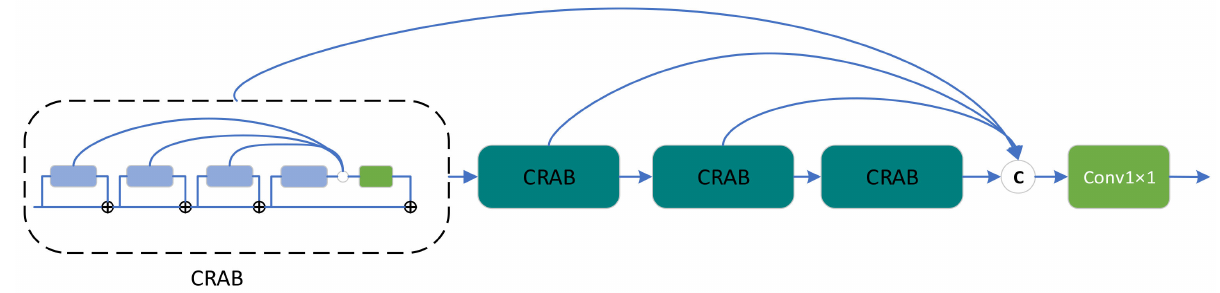
Figure 3. Detailed structure diagram of a double-stack feature aggregation module (DSFAM).